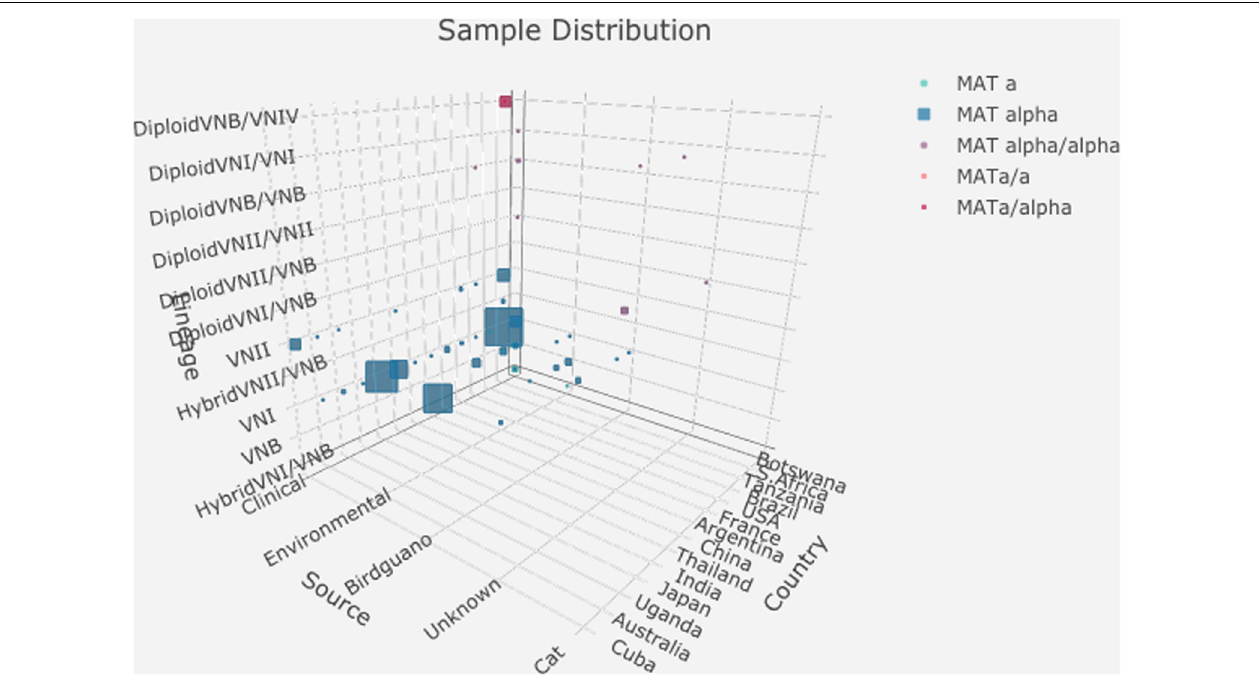
FIGURE 1 | Distributions of 188 strains based on their geographic origin, ecological niche, mating type, and nuclear ploidy, and clade. The detailed data used to generate this graph is presented in Supplementary Table S2